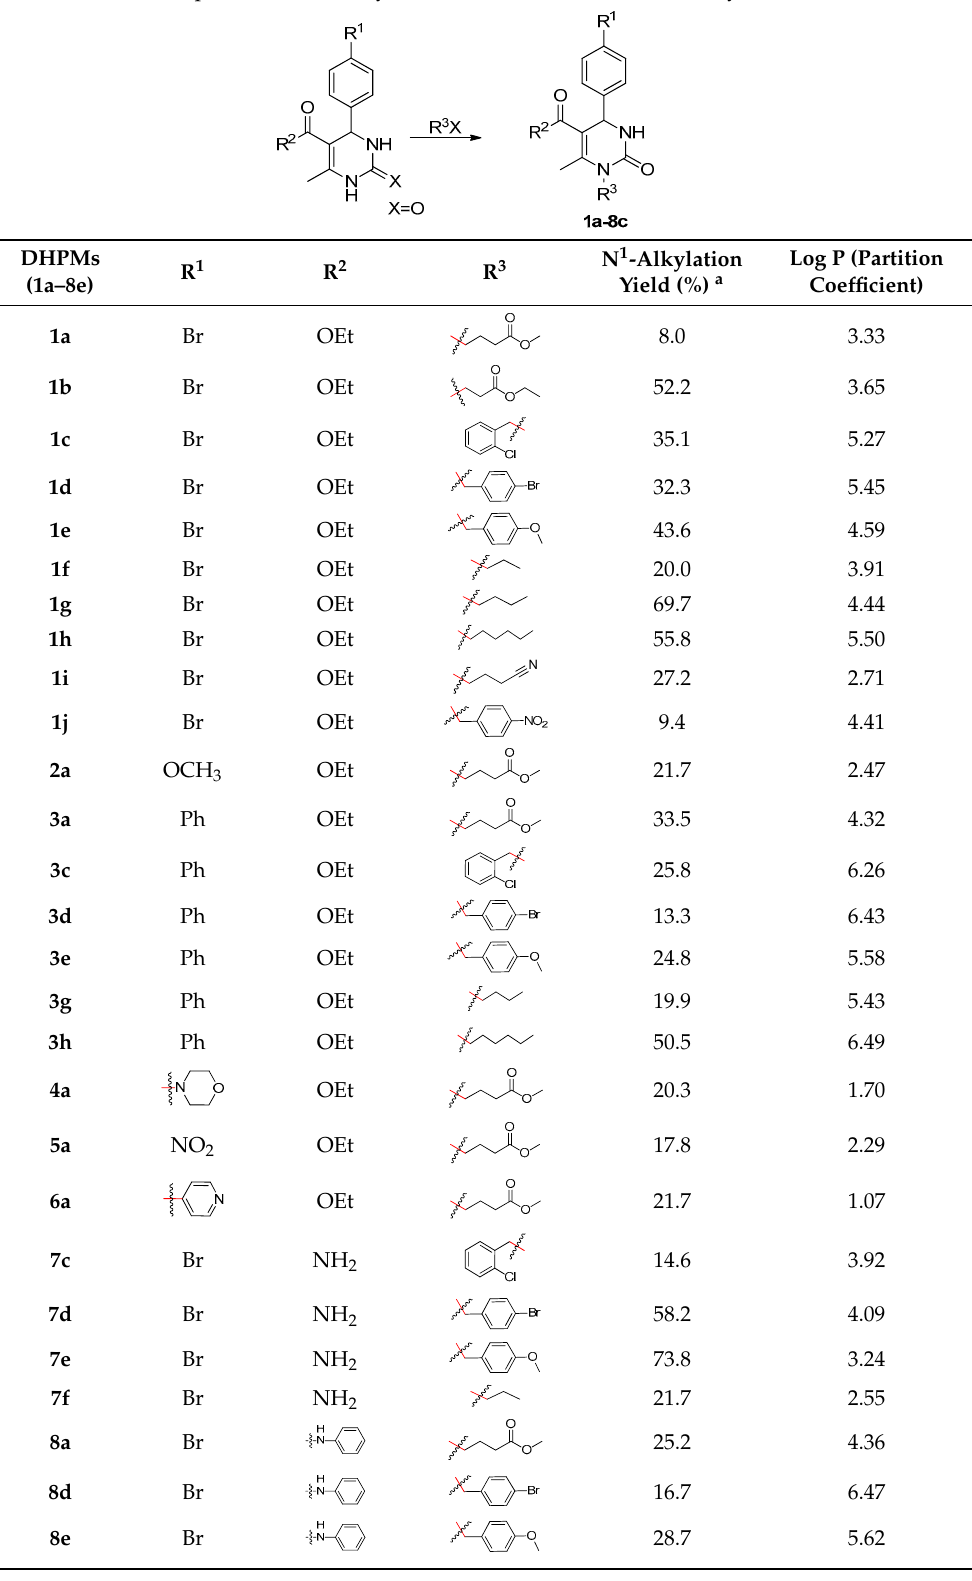
Table 1. Preparation of N 1 -alkylated DHPMs with different halohydrocarbons.